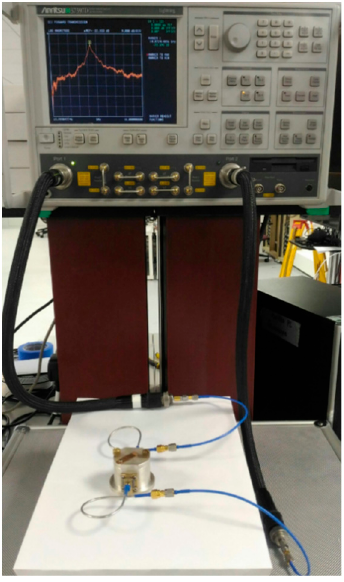
Figure 8. TE 01 δ mode cavity resonator system during measurement.